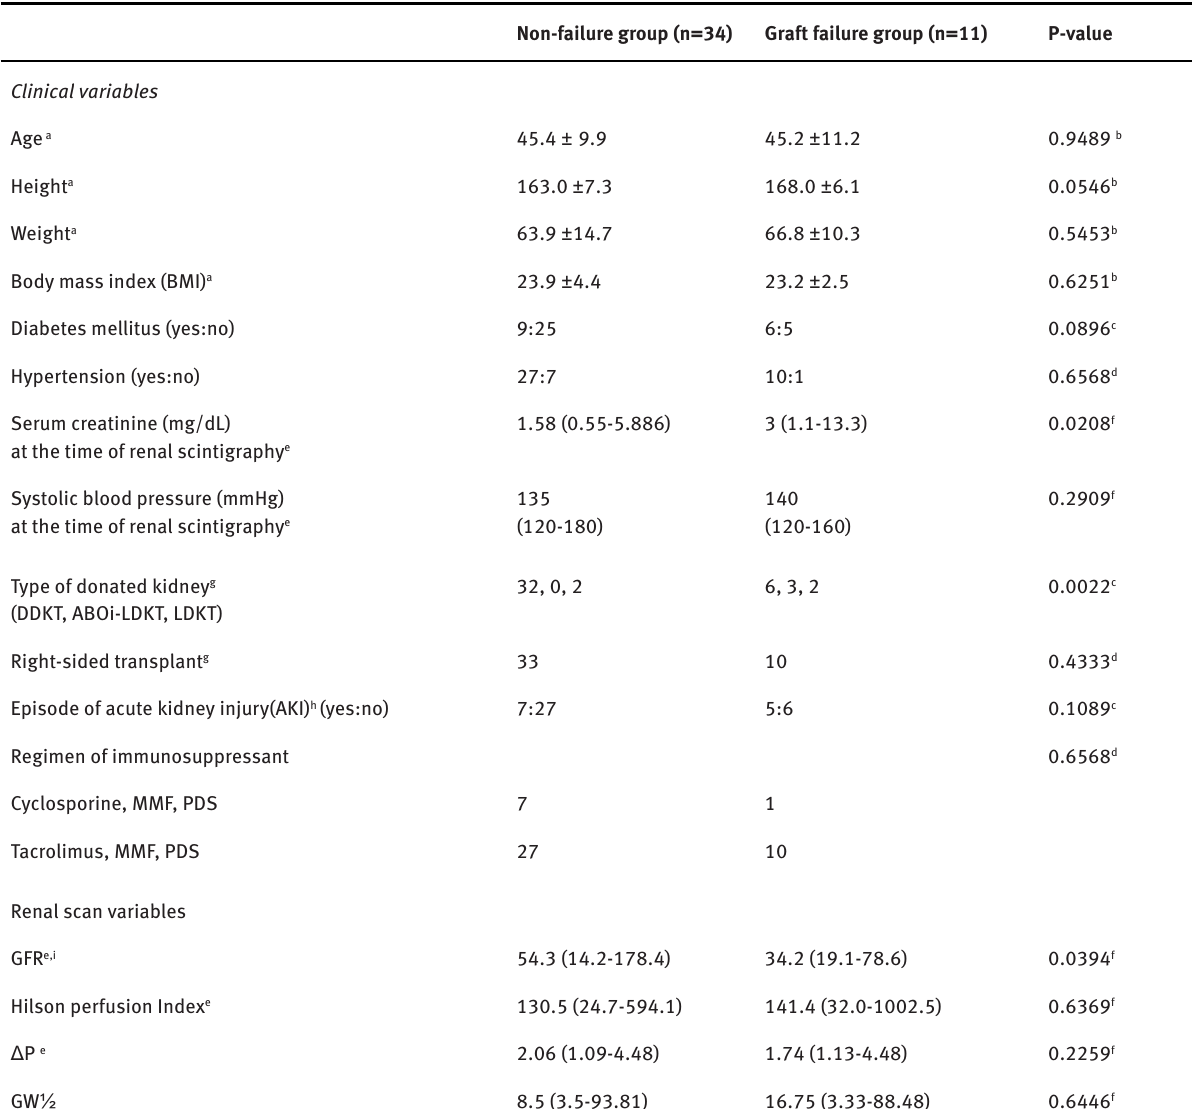
Table 2: Comparison between